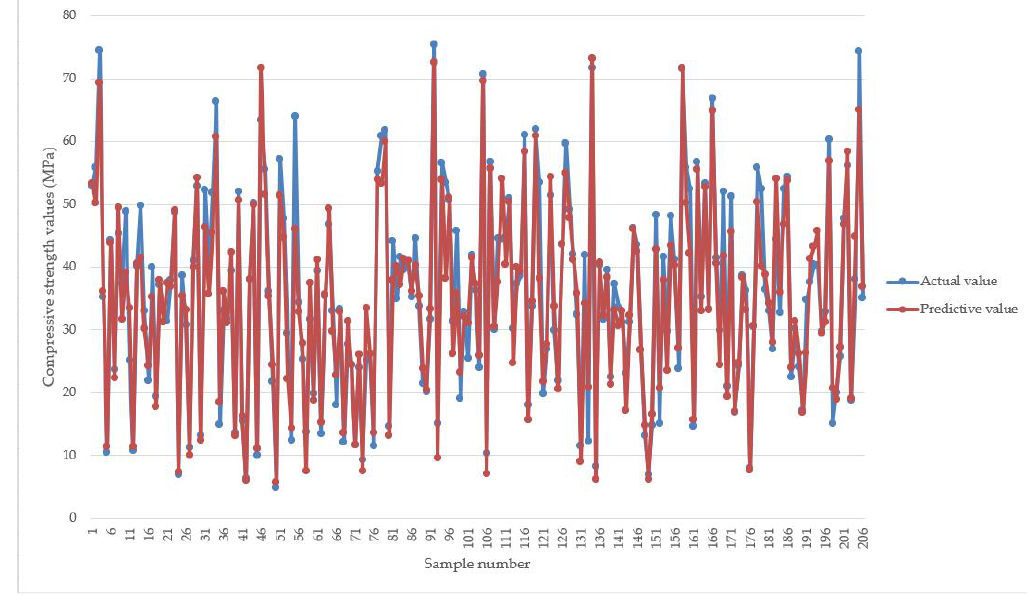
Figure 15. Scatter plot analysis of predicted and tested values in the test set.